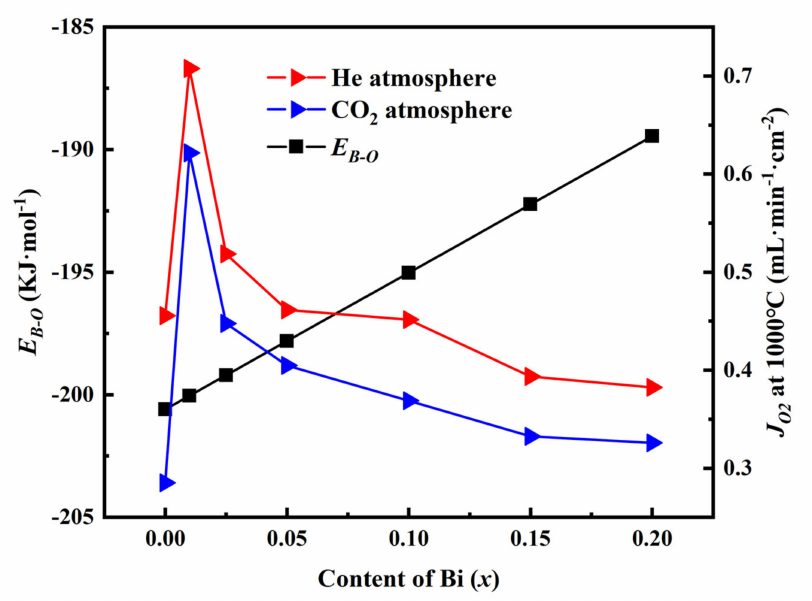
Figure 6. Relationship between oxygen permeation fluxes ( J O2 ) through 60CPO-40PSF 1 − x B x O OTMs under He or CO 2 atmosphere, ABE of B-O bonds, and contents of Bi ( x ). J O2 for x = 0 is from reference